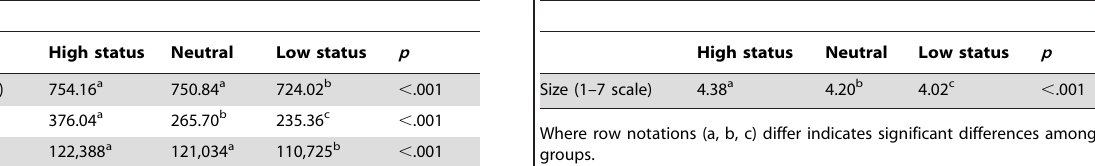
Table 3. Measured size as a function of status cues in Experiment 3.